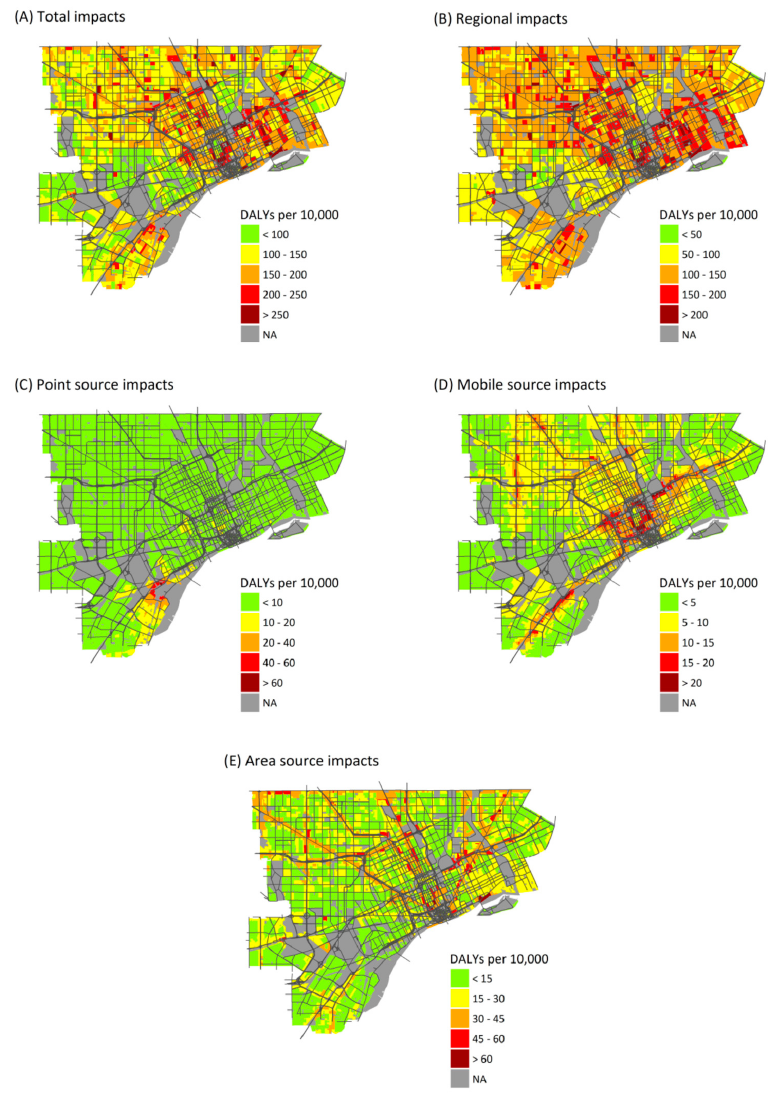
Figure 2. Maps showing the annual health burden as DALYs per 10,000 persons per year attributable to to exposures from: all sources ( A ); and exposures from: regional sources ( B ); point sources ( C ); mobile sources ( D ); and area sources ( E ).